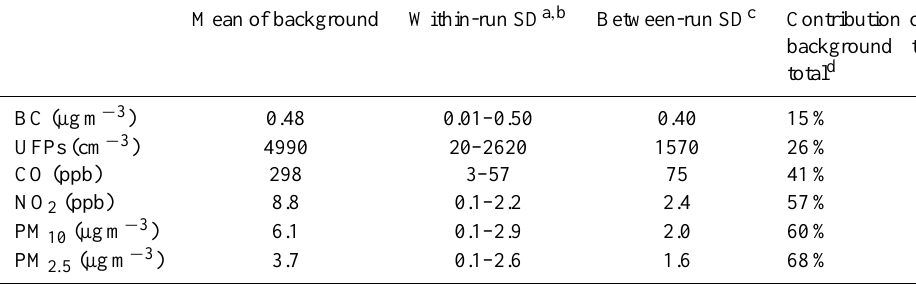
Figure 6. Comparison of location-based (median of measured background concentrations) and time-series-based (spline of minimums) background estimates. Time-series-based estimates were calculated using all of the data and after the measurements in areas designated as background had been removed. Dashed black lines represent y = x . Table 3. Summary comparison of pollutant background concentration and